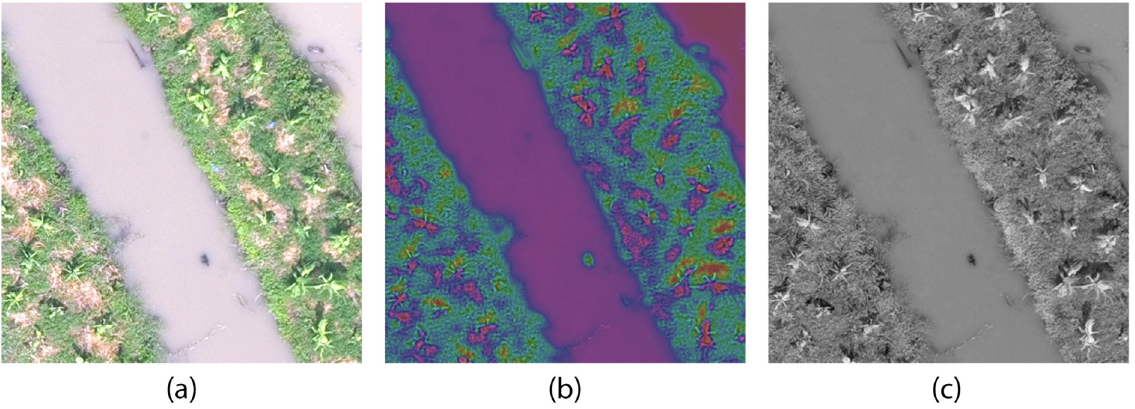
Fig 5. Sample image tiles of 40m altitude variant. (a) LCS ( p 1 ), (b) SCT ( p 2 ) and (c) TGI ( p 3 ).